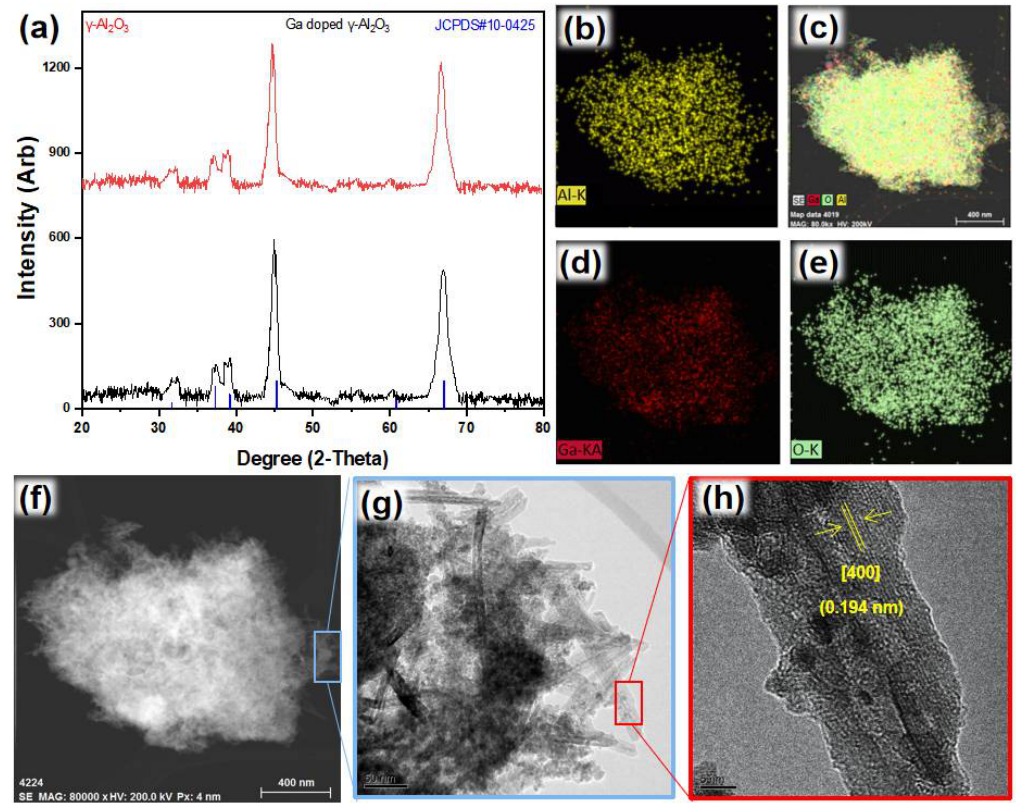
Figure 1. ( a ) XRD, ( b – e ) TEM-EDS, ( f – g ) TEM and ( h ) HRTEM of Ga-substituted γ-Al 2 O 3 .